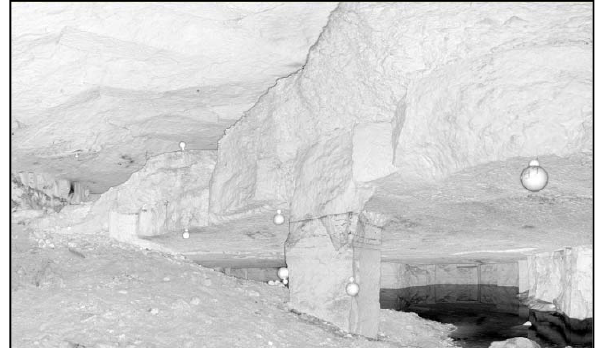
Figure 5. Targets